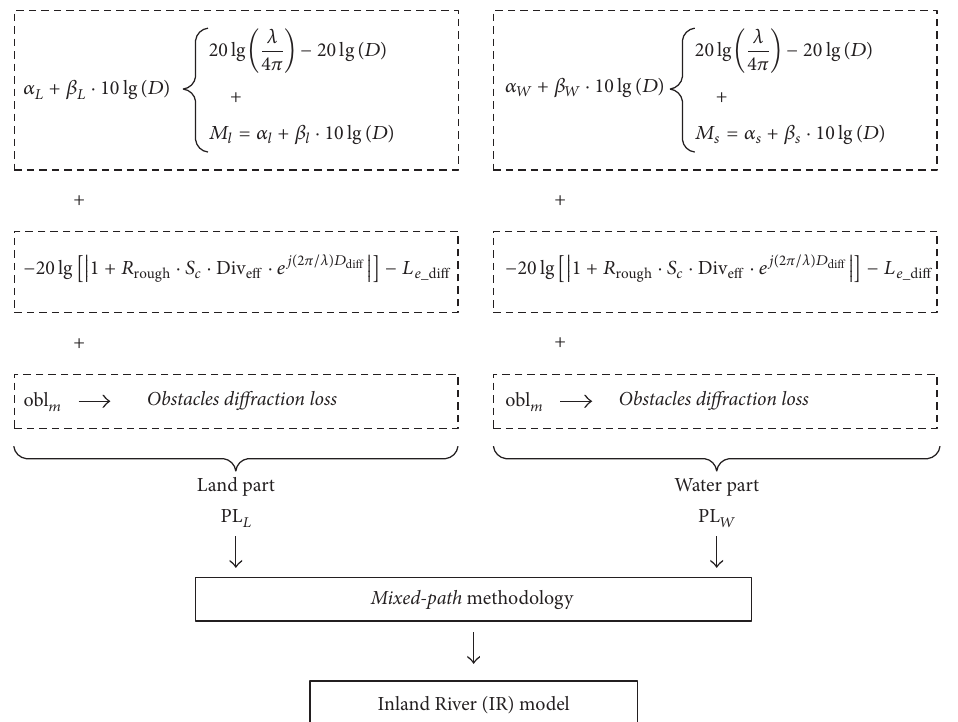
Figure 3: The structure of Inland River